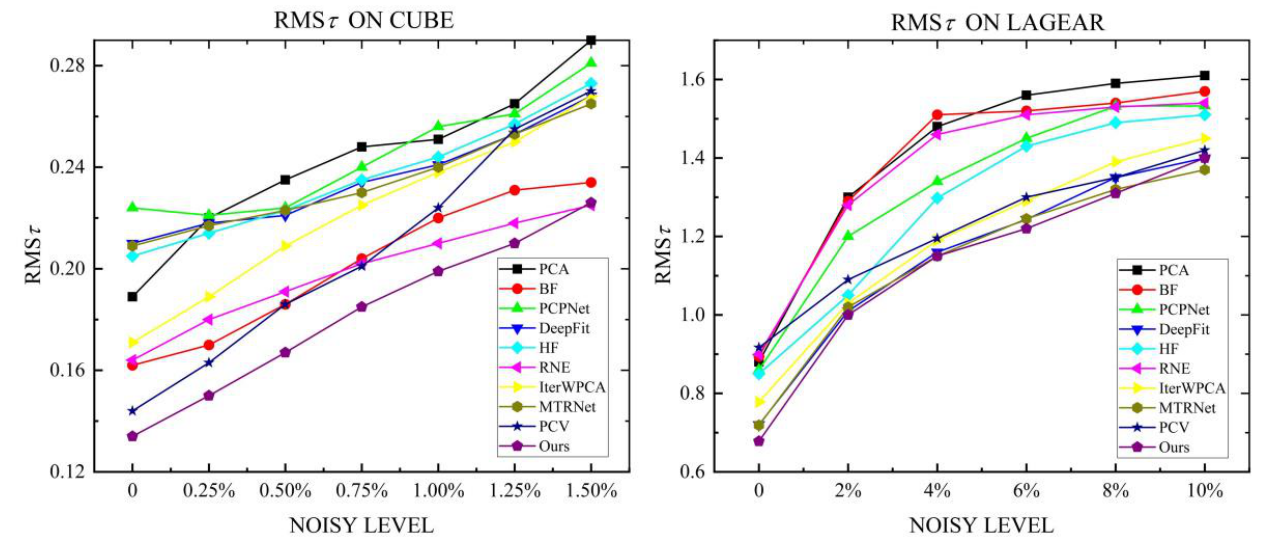
Figure 8. Comparison of the robustness of different algorithms to noise on Cube models with small noise levels and Lagera models with large noise levels.